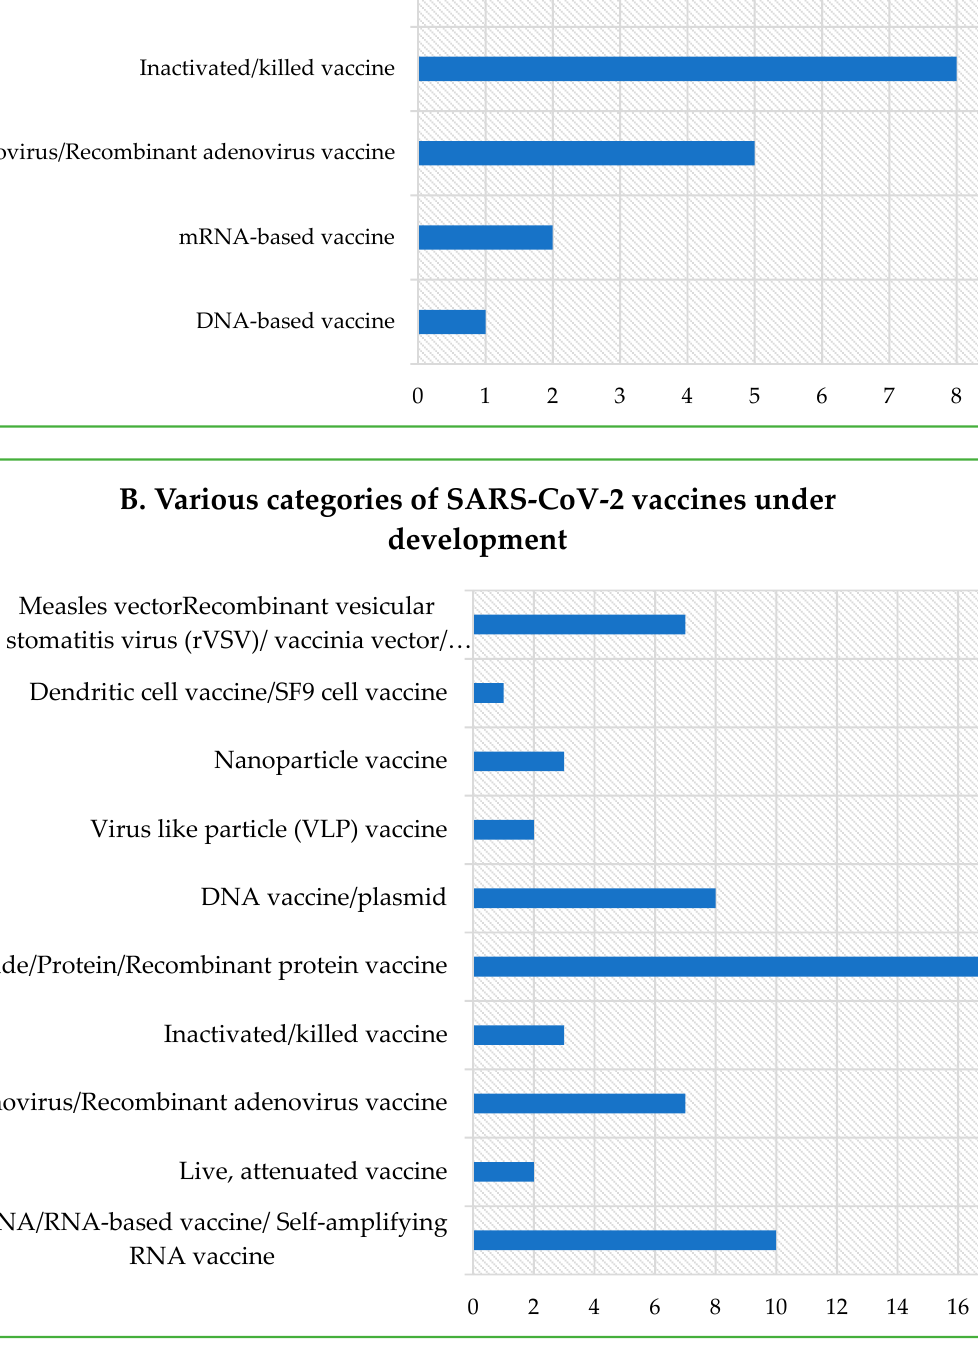
Figure 2. Nature of SARS-CoV-2/COVID-19 vaccines being developed and administered worldwide. ( A ) Nature/categories of authorized vaccines. ( B ) Nature of vaccines under various phases of pre-clinical and clinical development.